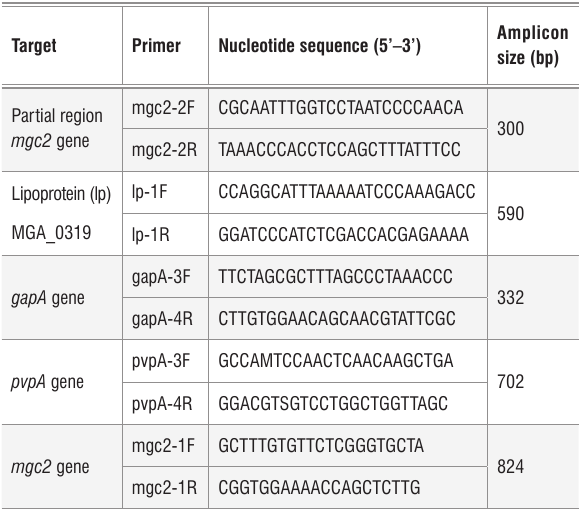
genome coding sequence low